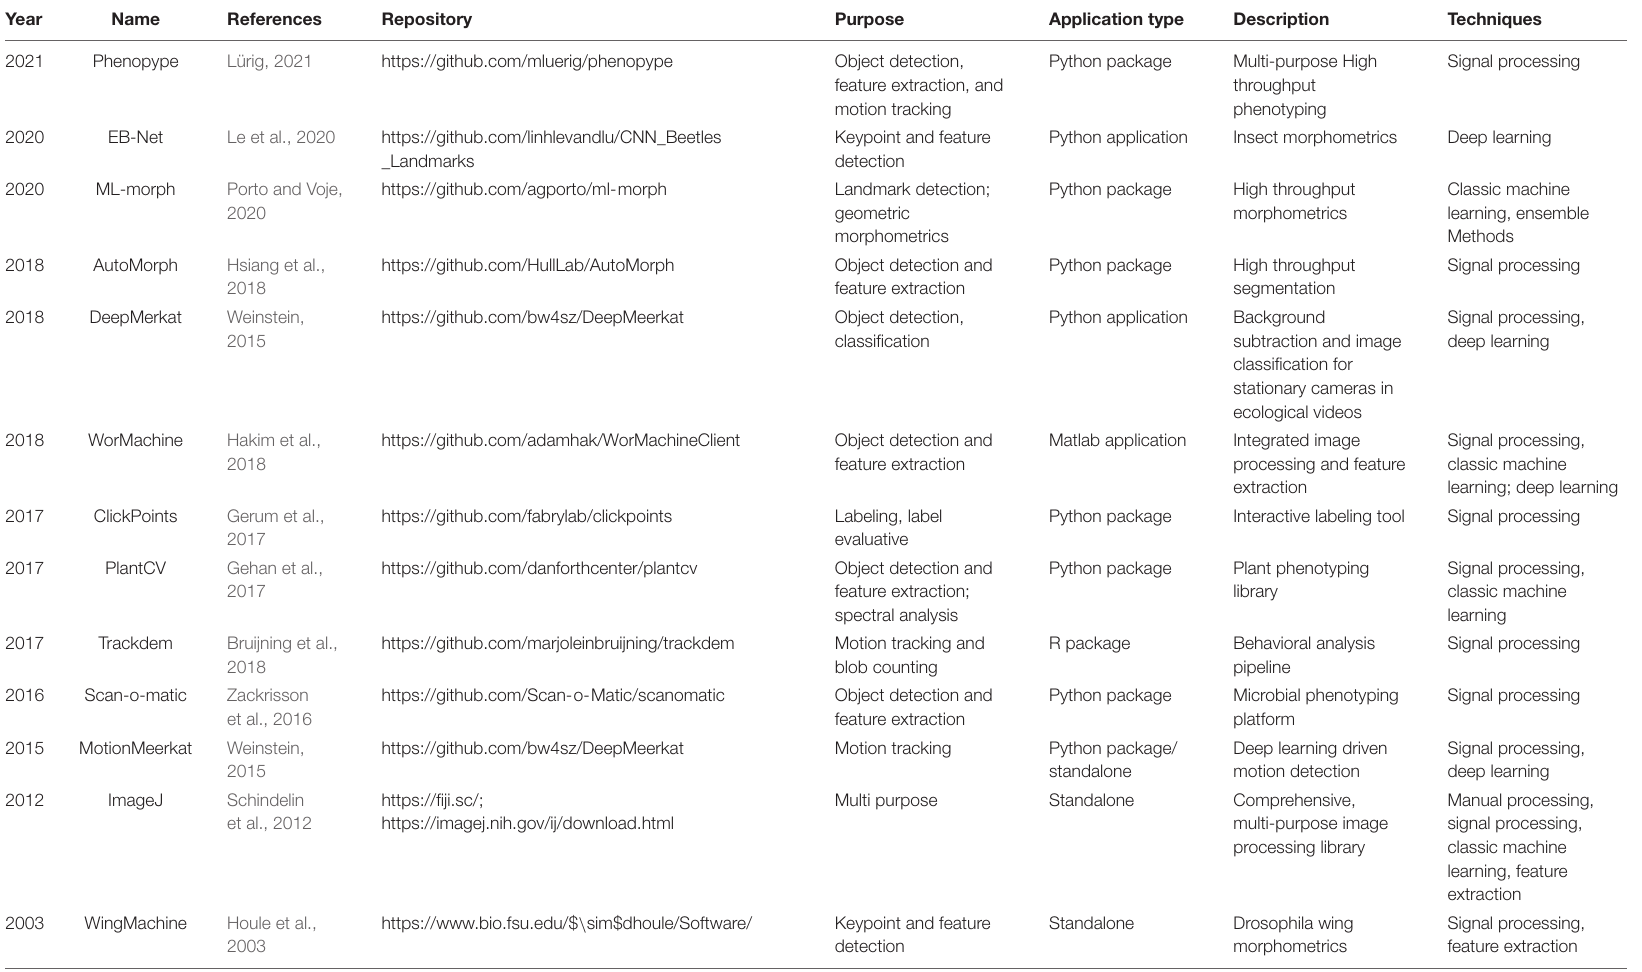
TABLE 2 | Select examples of recent open source computer vision libraries with a